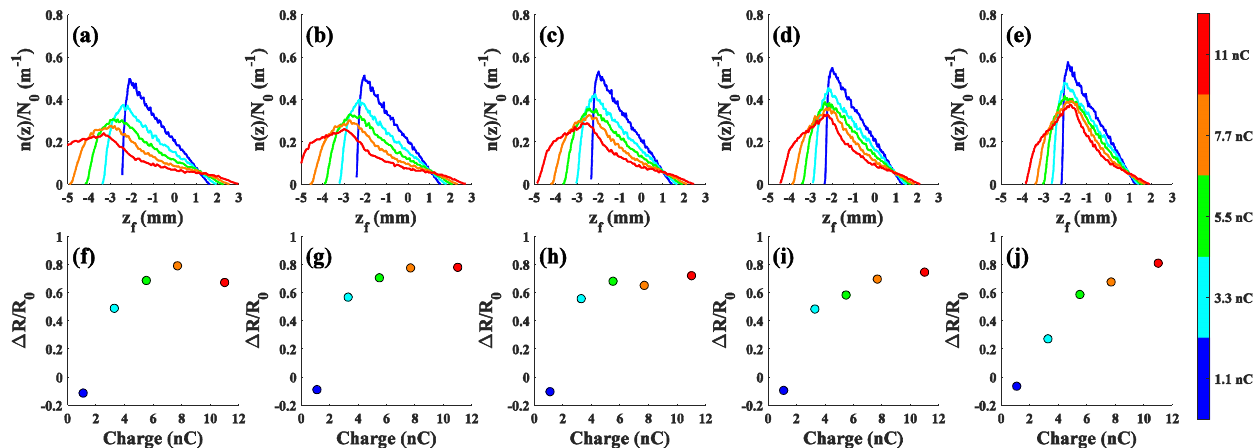
FIG. 11. The space charge effect. Current profiles at the end of the EEX beam line with different charges after the mask (top), and corresponding transformer ratio drop (bottom). As we move from left to right (a) – (e), α 2 ¼ ð 20 0 ; 18 0 ; 16 0 ; 14 0 ; 12 0 Þ and L 0 . 85 m ; 1 . 00 m ; 1 . 19 m ; 1 . 43 m ; 1 . 74 m Þ ). Corresponding ξ D 2 ¼ ð 2 for each case is (0.14 m, 0.13 m, 0.11 m, 0.10 m, 0.09 m). The beam energy is 15 MeV that generates a weak CSR effect but a strong space-charge effect.